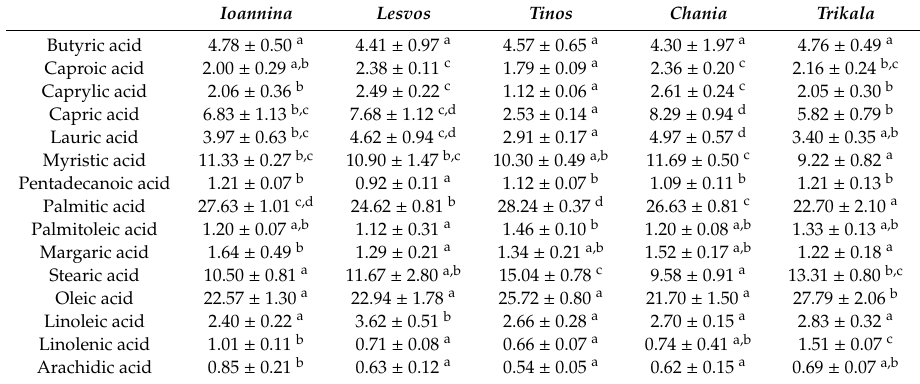
Table 4. Mean values and SDs of the percentages of fatty acids (% fatty acids) for the graviera cheese samples